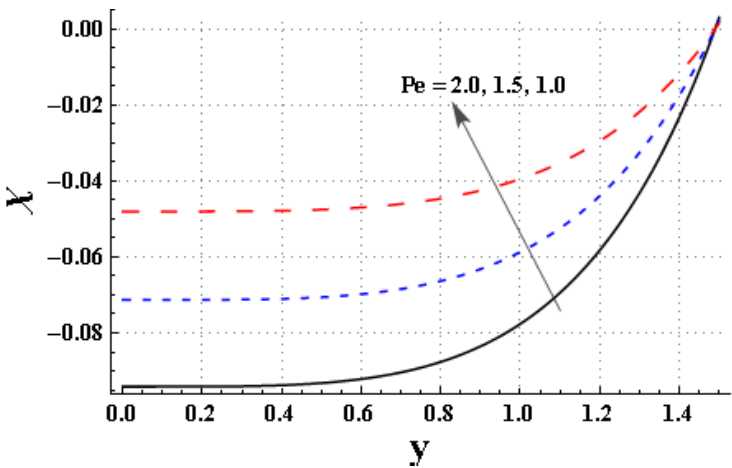
Figure 18. Effect of the Peclet number, Pe , on the concentration of motile microorganisms, χ .